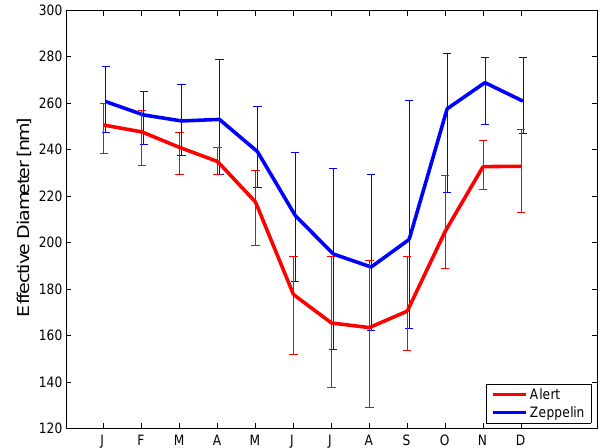
Figure 2. Measurement monthly median aerosol effective diameter from SMPS and DMPS at the two high-Arctic sites, Alert (2011– 2013), and Mt. Zeppelin (2011–2013) respectively for particle sizes between 20 and 500nm. Error bars show the 20th and 80th per- centiles.